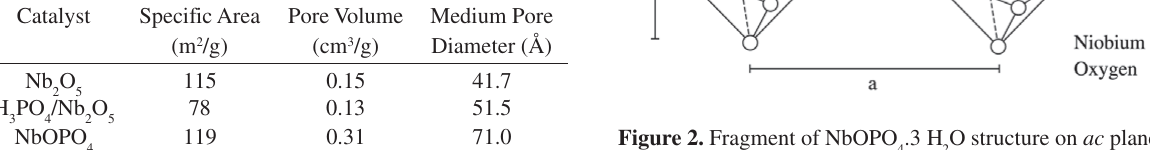
.3 H O structure on ac 4 2